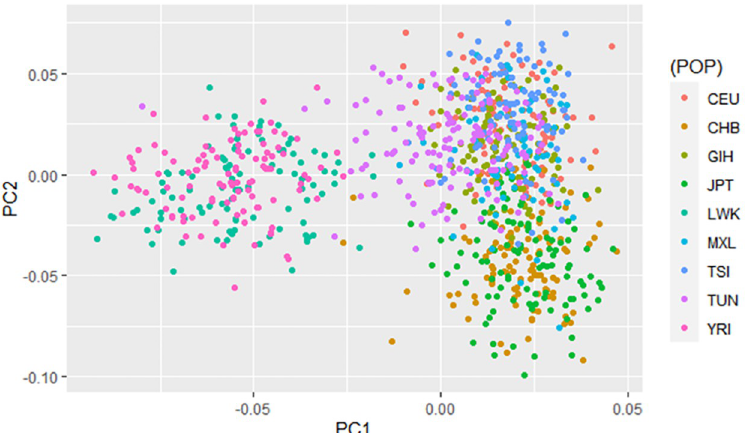
Fig 3. Principal component analysis of high and moderate penetrance susceptibility genes. The first two principal components (PCs) are plotted and coloured according to population ancestry.